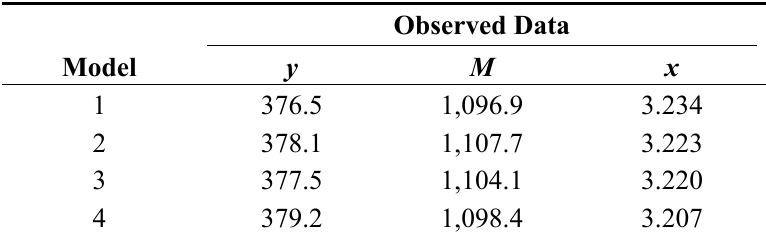
Table 1. Deviance information